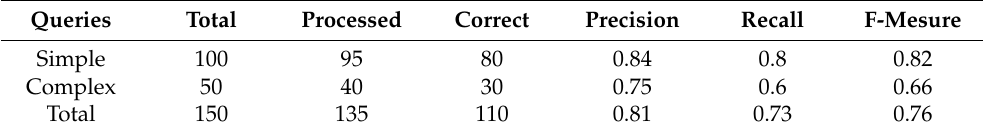
Table 4. QALD-9 test dataset results.